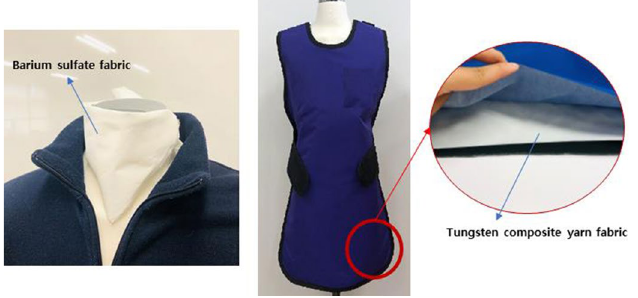
Figure 7. Prototype radiation shield clothing: ( a ) scarf made from PET containing BaSO 4 and ( b ) (with inset) apron and radiation shield clothing items manufactured using the tungsten composite